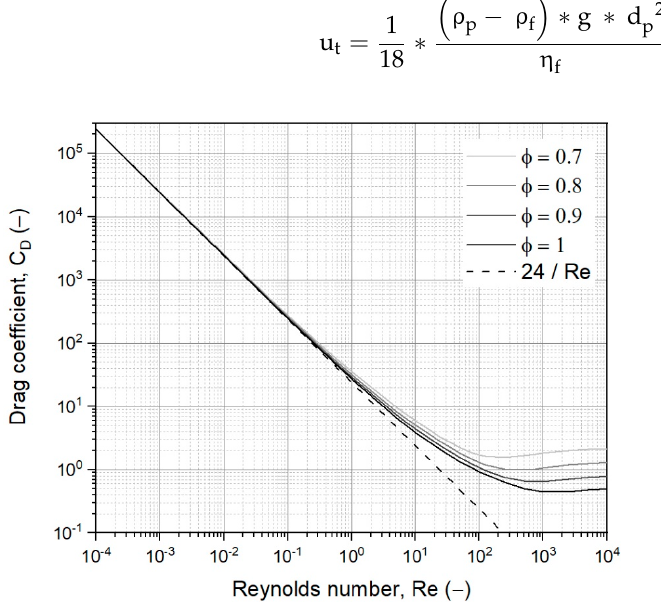
Figure 3. Drag coefficient for a single free-falling particle as a function of the Reynolds number based on Haider and Levenspiel [41], solid lines, and the simplification for laminar flow, the dashed line.